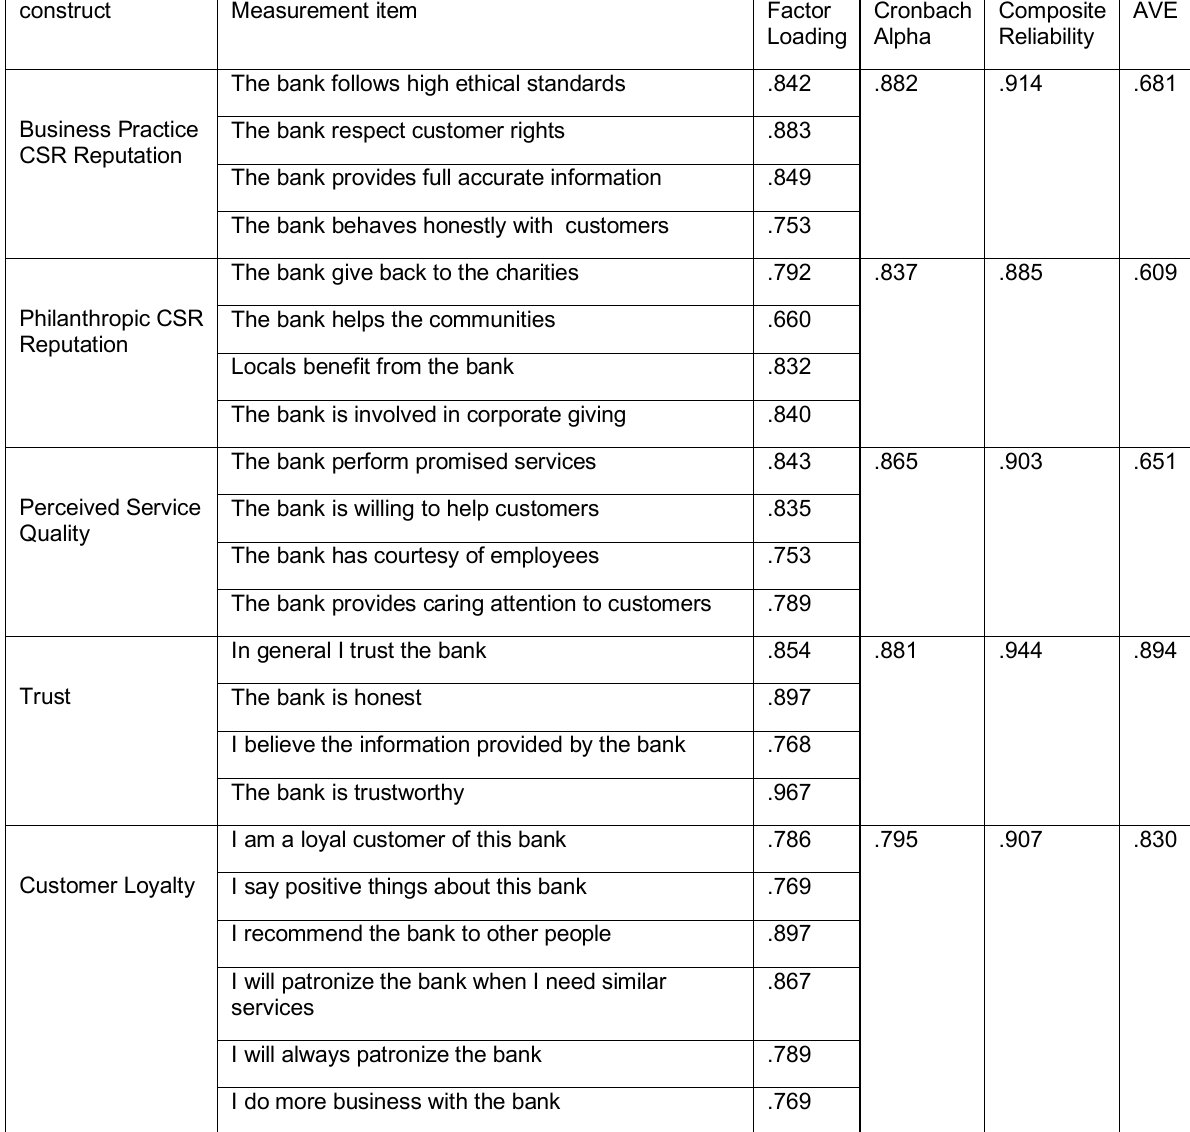
Table 2: Measurement items, validity and reliability analyses